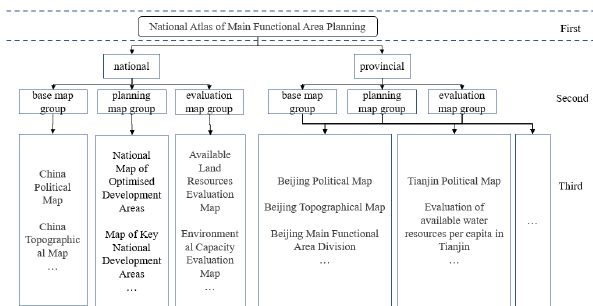
Figure 2 . Overall structure of the National Atlas of Main Functional Area